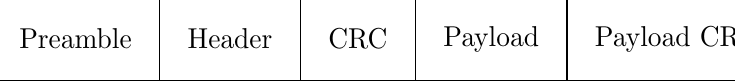
Figure 6. LoRa frame